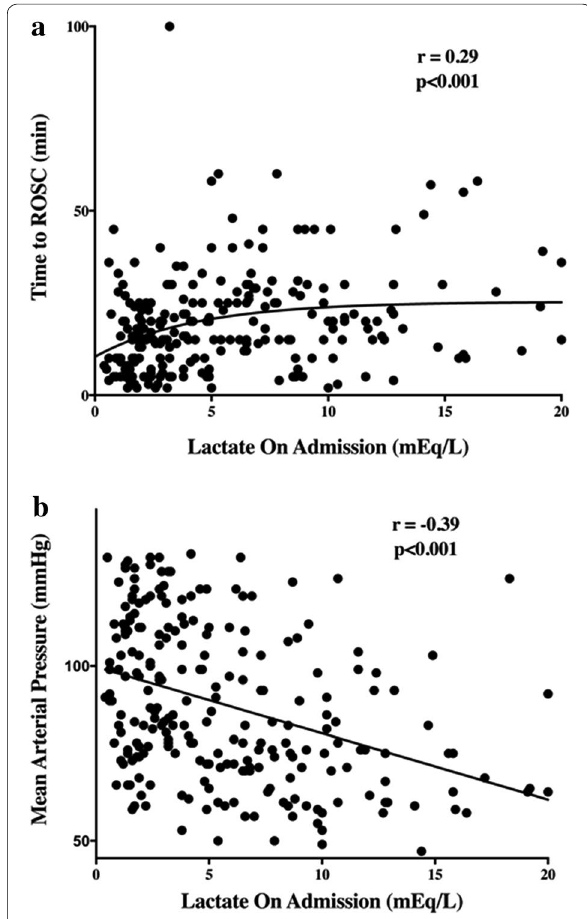
Fig. 1 Panel A: Correlation between blood lactate concentration on admission and the time to return of spontaneous circulation (ROSC) ( r 0.29; p < 0.001). Panel B: Correlation between blood lactate con‑ = centration on admission and the first recorded mean arterial pressure (MAP) ( r 0.39; p < 0.001) = −